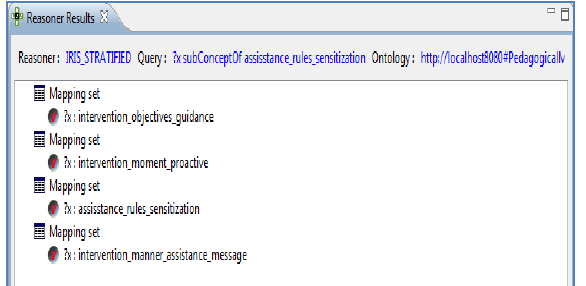
Figure 5. Result of query applied on the pedagogical ontology